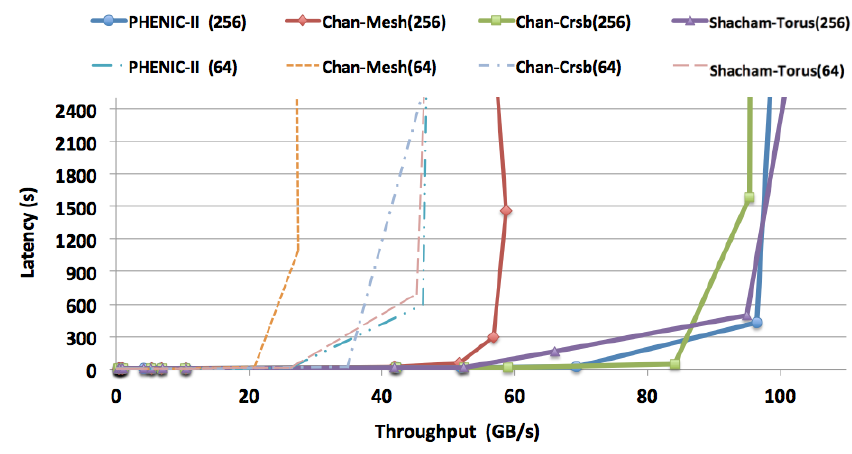
Figure 13. Throughput vs . latency under random traffic.